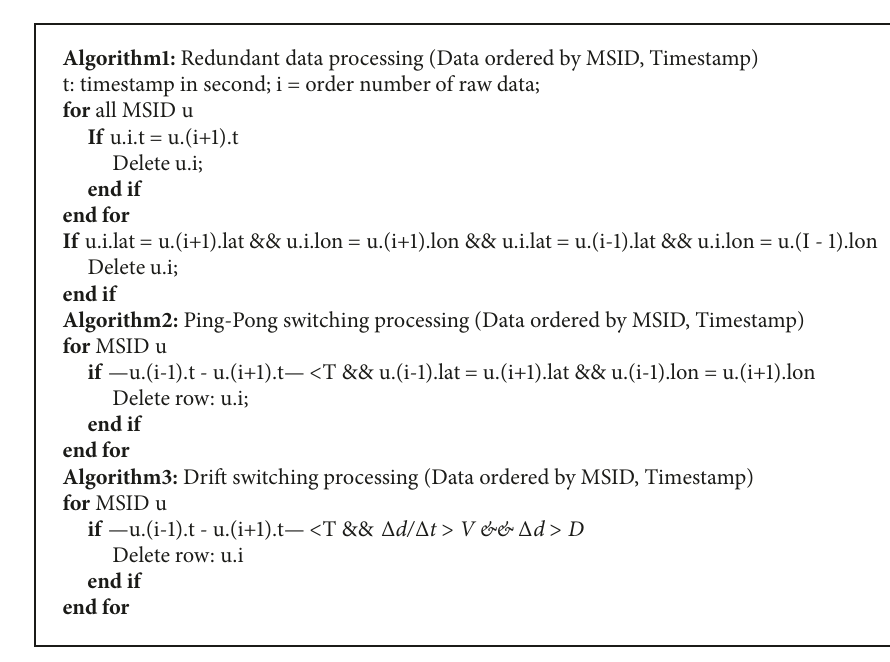
Algorithm3: Drift switching processing (Data ordered by MSID,